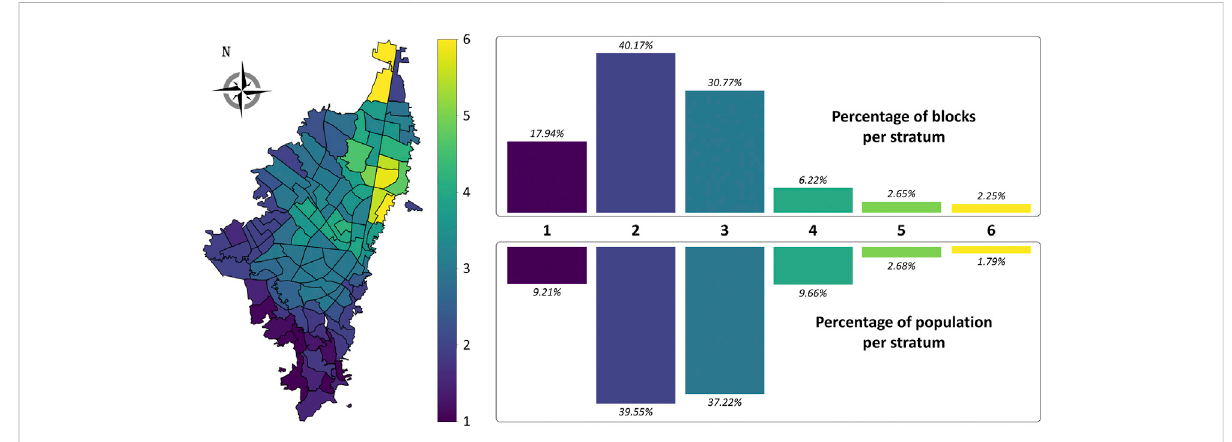
FIGURE 9 Distribution of socio-economic stratum in the city of Bogotá. At the left, spatial distribution of strata across the UPZs. At the right, overall distribution of strata across blocks and